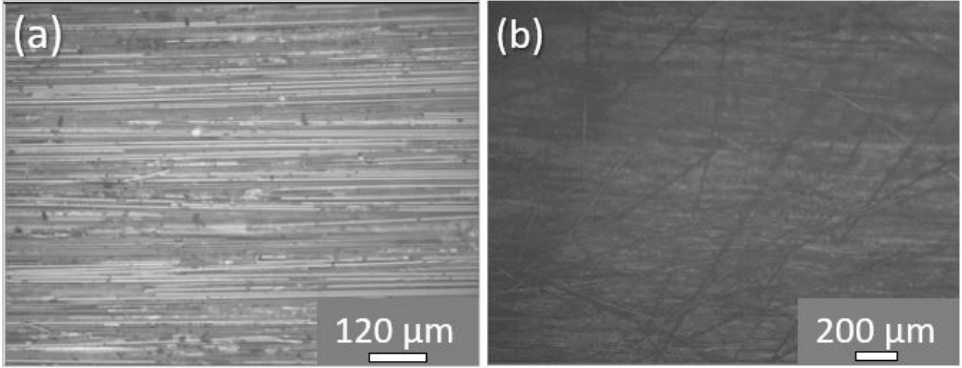
Figure 7. Representative optical microscopy images from the fractured surface of ( a ) a reference and ( b ) a modified CFRP.